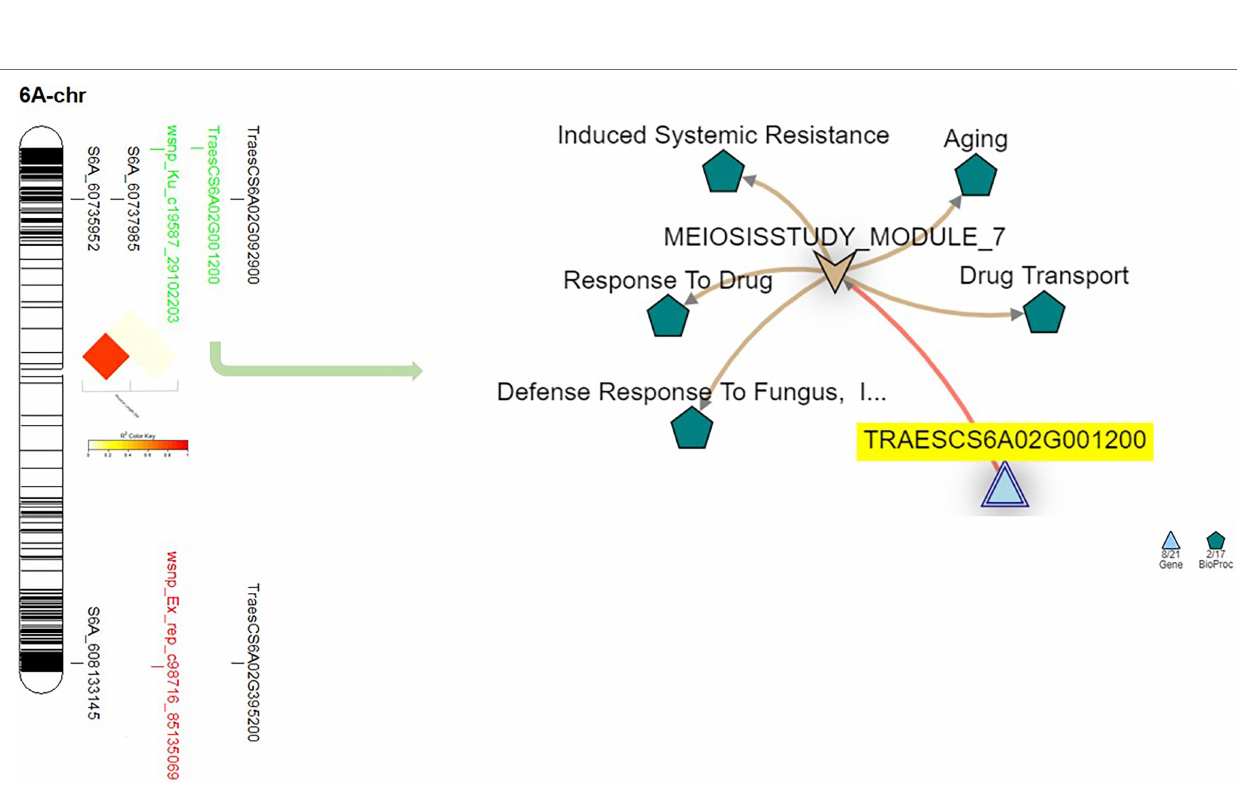
FIGURE 5 | The linkage disequilibrium between each pair of the significant markers identified on 6A chromosome, the gene model they are harboring, and the gene network of the identified gene models in related to disease